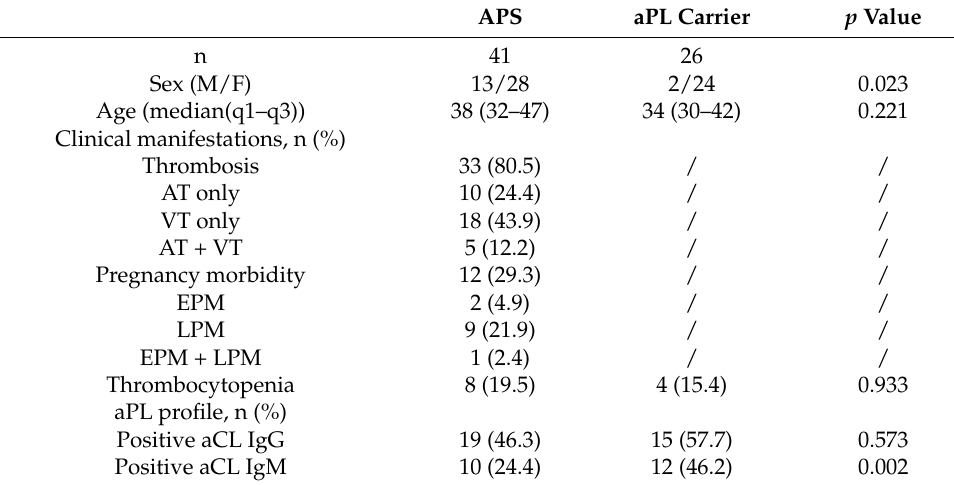
Figure 1. The illustrative figure for the summary of this study. Table 1. Baseline characteristics of the enrolled aPL(+)